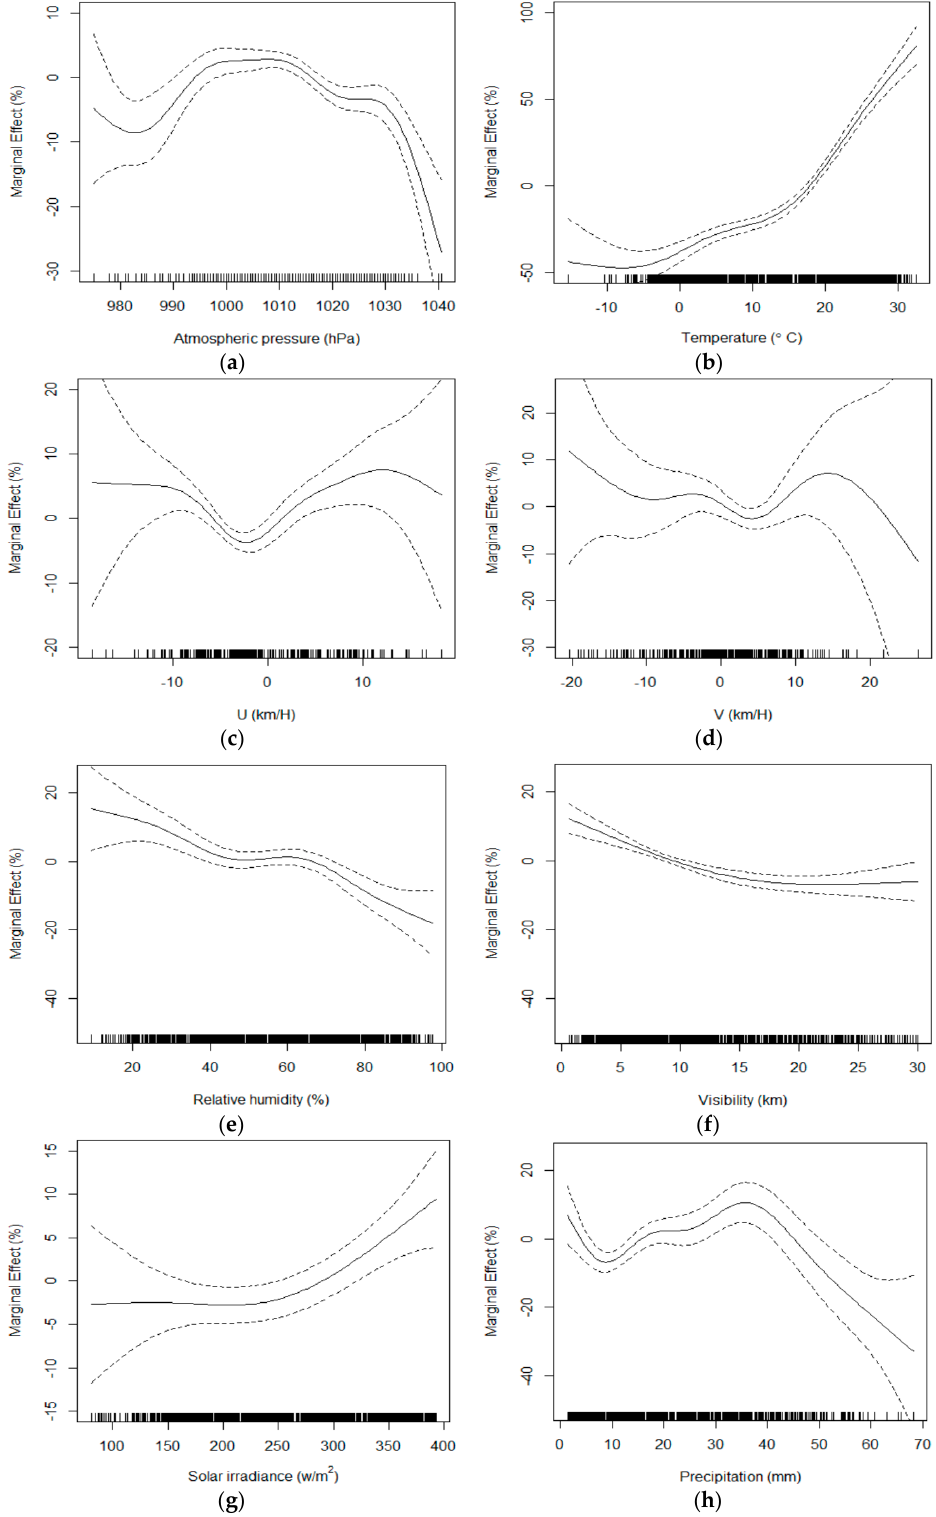
Figure 4. Partial residual plot for O 3 . ( a ) atmospheric pressure; ( b ) temperature; ( c ) zonal ( u ) wind; ( d ) meridional ( v ) wind; ( e ) relative humidity; ( f ) visibility; ( g ) solar irradiance; ( h ) precipitation. The abscissa represents the magnitude of each meteorological variable. The ordinate represents the marginal effect, which is the impact of various meteorological variables on air pollutants. The dashed line is the 95% confidence interval and the short line perpendicular to the abscissa represents the distribution frequency of each meteorological variable.